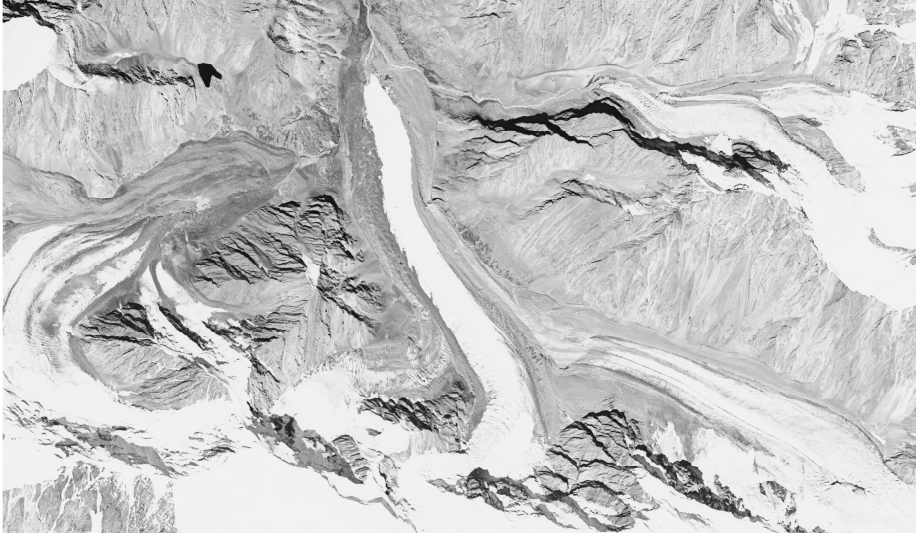
Figure 16. Bolshoi Maashei glacier; fragment of a 1968 Corona image.